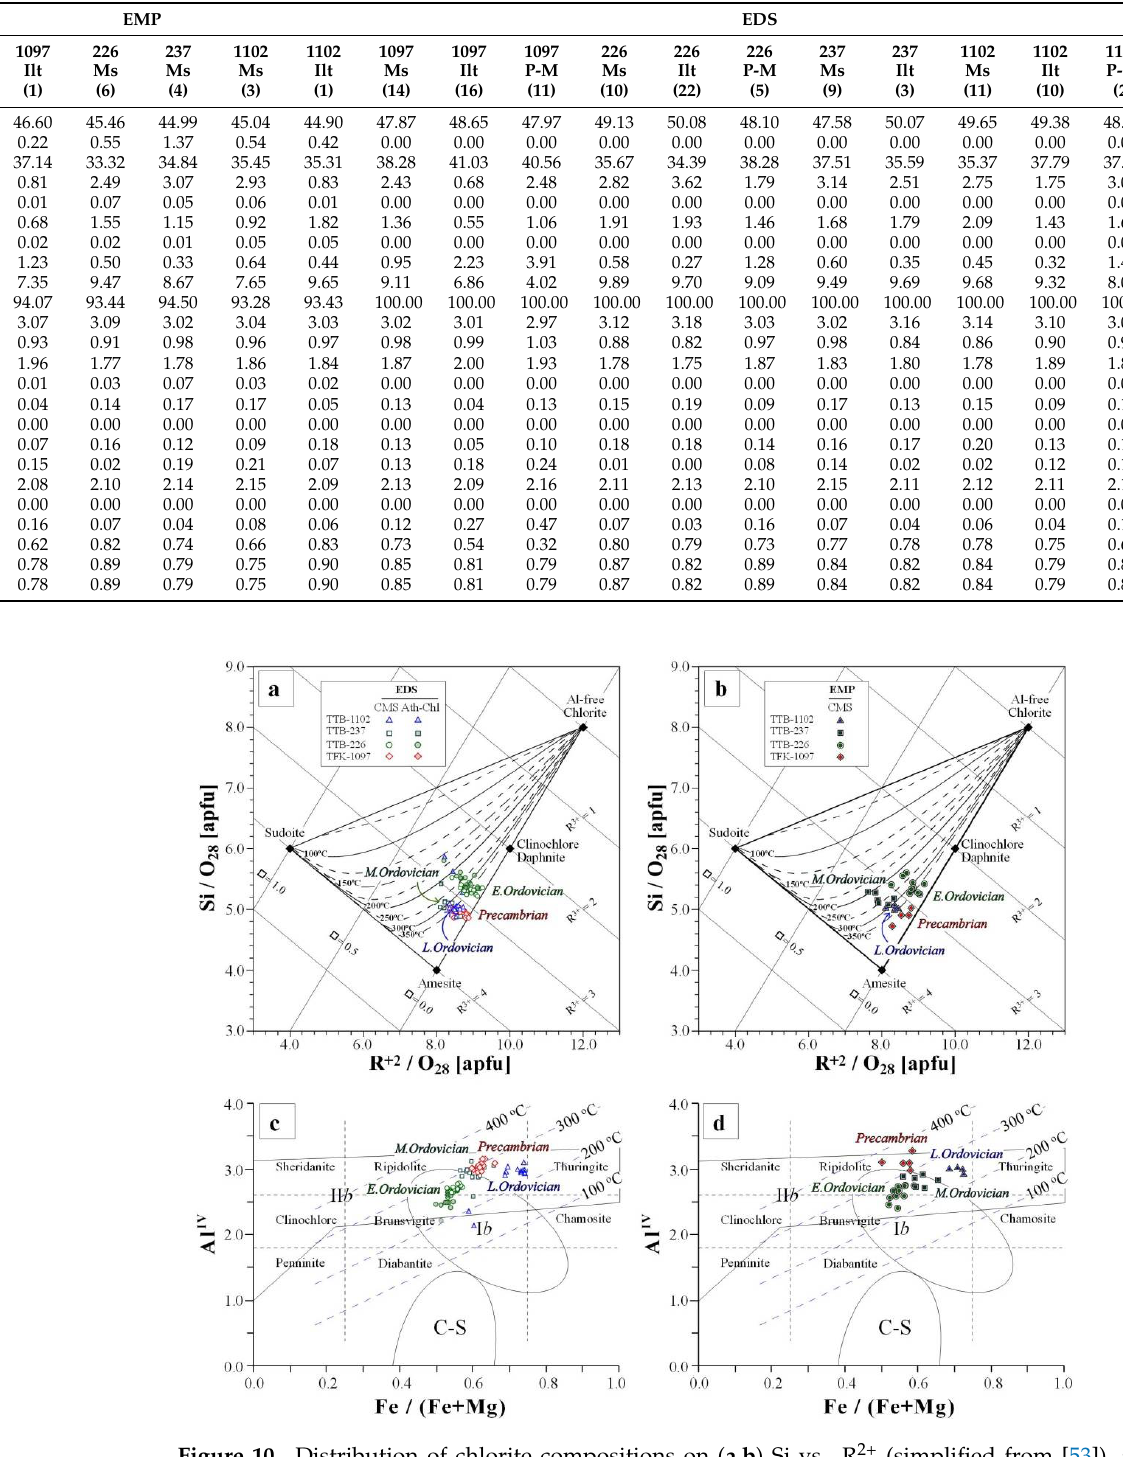
Figure 10. Distribution of chlorite compositions on ( a , b ) Si vs. R 2+ (simplified from [53]), and ( c , d ) Al IV vs. Fe/(Fe + Mg) diagram (modified from [54]; IIb chlorite area and compositional limits from [55]; Ib and swelling chlorites (C-S) areas from [56]. ( a , c ) and ( b , d ) represent the analytical results by EDS and EMP, respectively. Temperature contours on Si − R 2+ and Al IV − Fe/(Fe + Mg) diagrams are from [30] and [52], respectively.